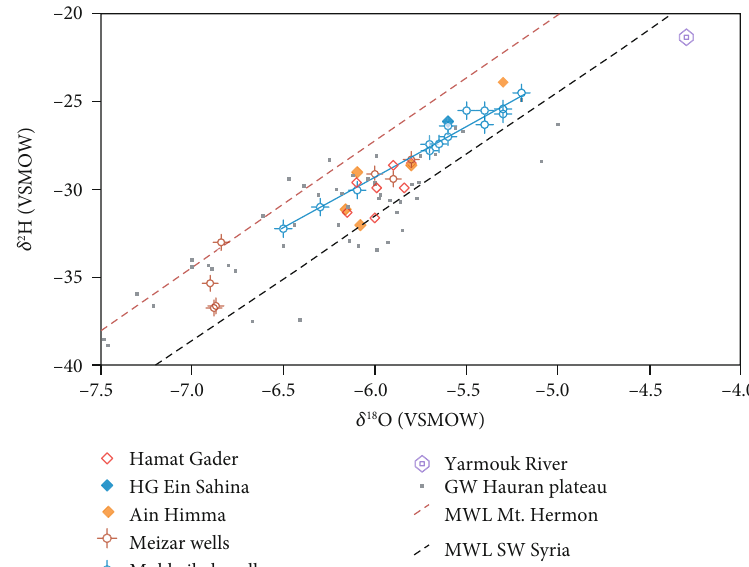
Figure 8: δ D vs. δ 18 O in groundwater of the Lower Yarmouk Gorge ([1]; this study) and the Hauran plateau [18]. MWL for Mt. Hermon and SW Syria are taken from Brielmann [52] and Al Charideh and Zakhem [53],